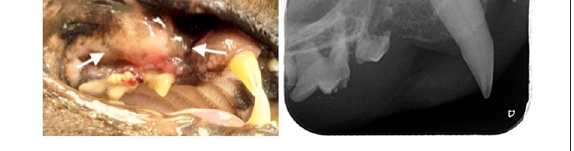
FIGURE1 Leishmaniosis nodular ulcero-hemorrhagic lesion (arrows) identified in the right maxilla in a 10-year-old cat (left), intra-oral radiography of the right maxillary premolars and molars where it is possible to identify tooth resorption and vertical bone loss associated with the lesion (right).